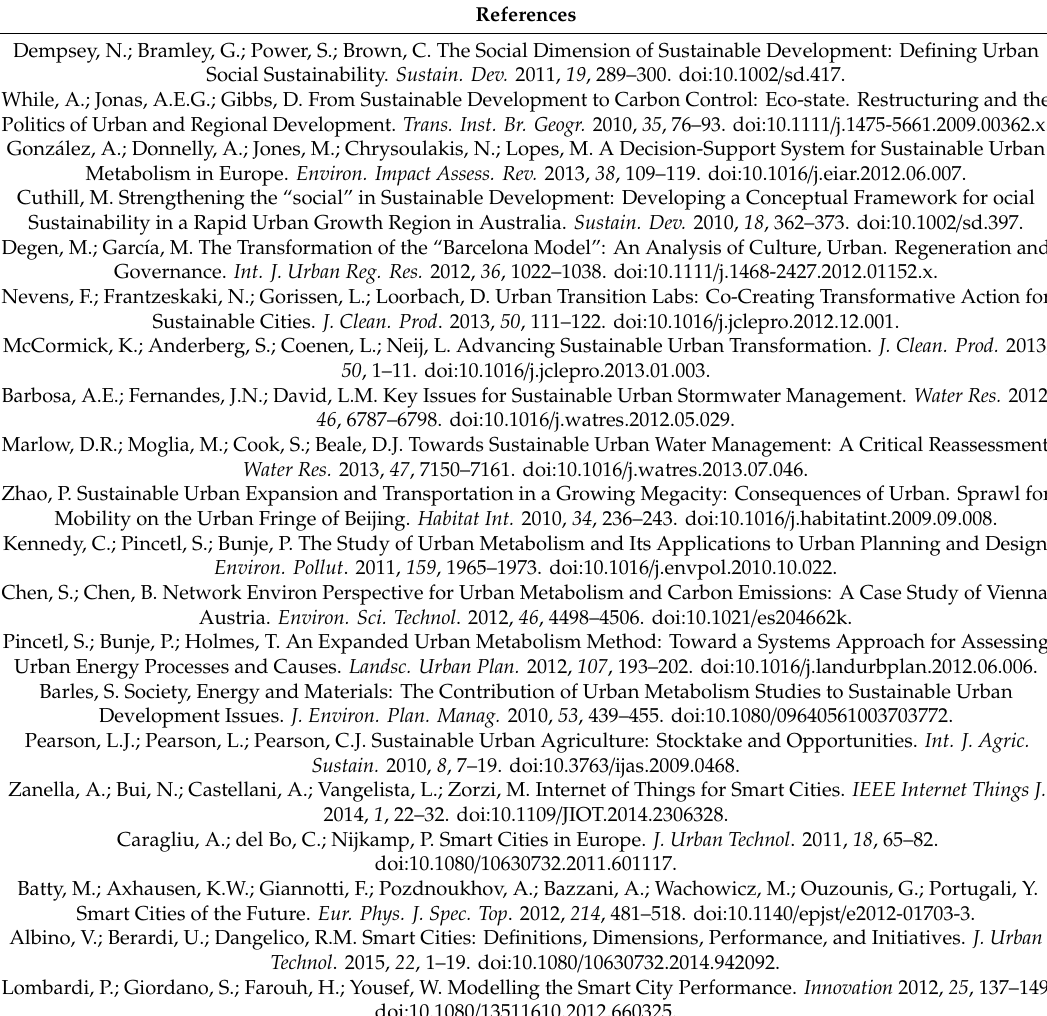
Table A3. References from obtained results as appear first in the